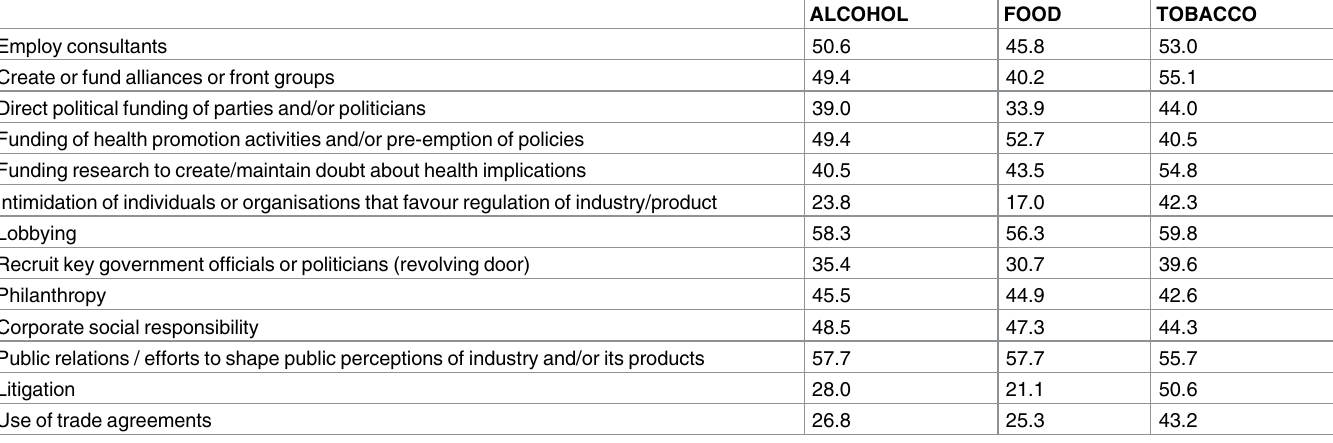
Table 1. Percentage of respondents indicating awareness of evidence for specific industry tactics to influence health policy (total N: 335). ALCOHOL FOOD